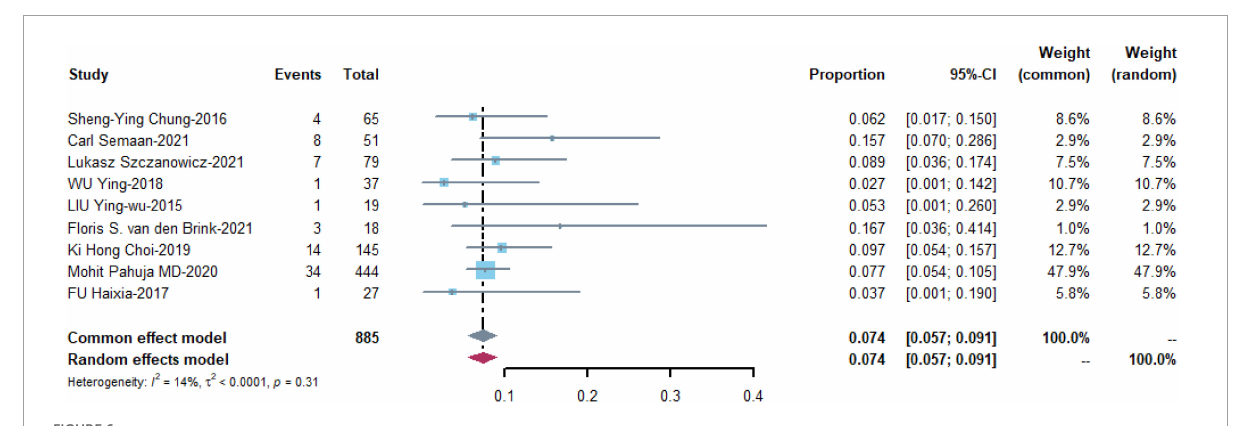
FIGURE6 Meta-analysis of the prevalence of leg